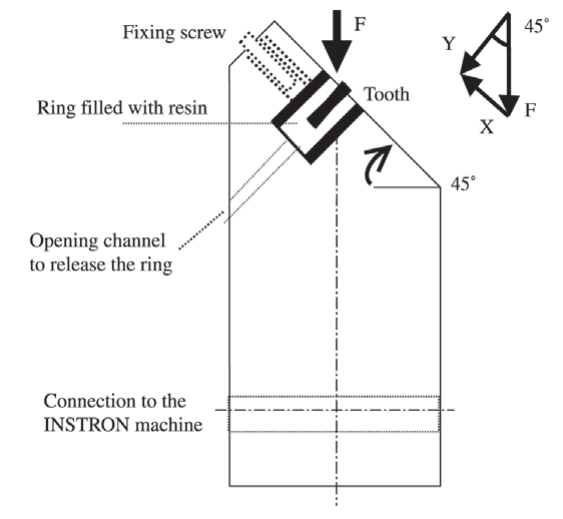
Figure 6 . Schematic view of the apparatus used during the tests.